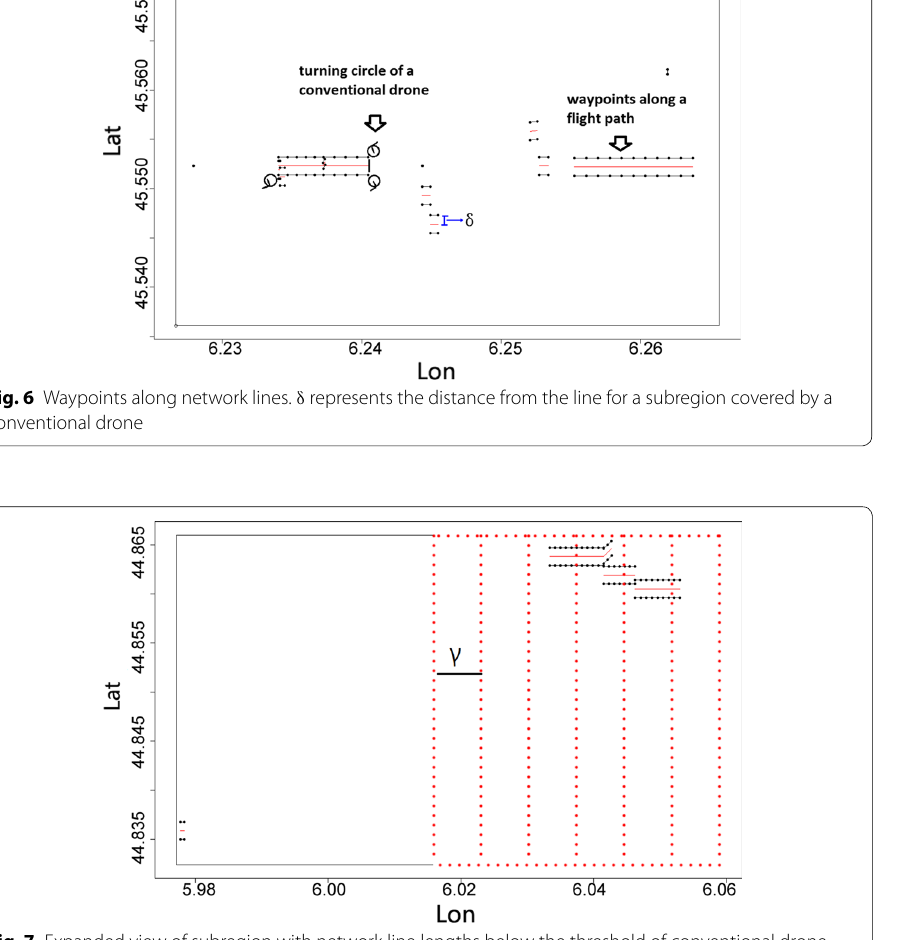
Fig. 7 Expanded view of subregion with network line lengths below the threshold of conventional drone